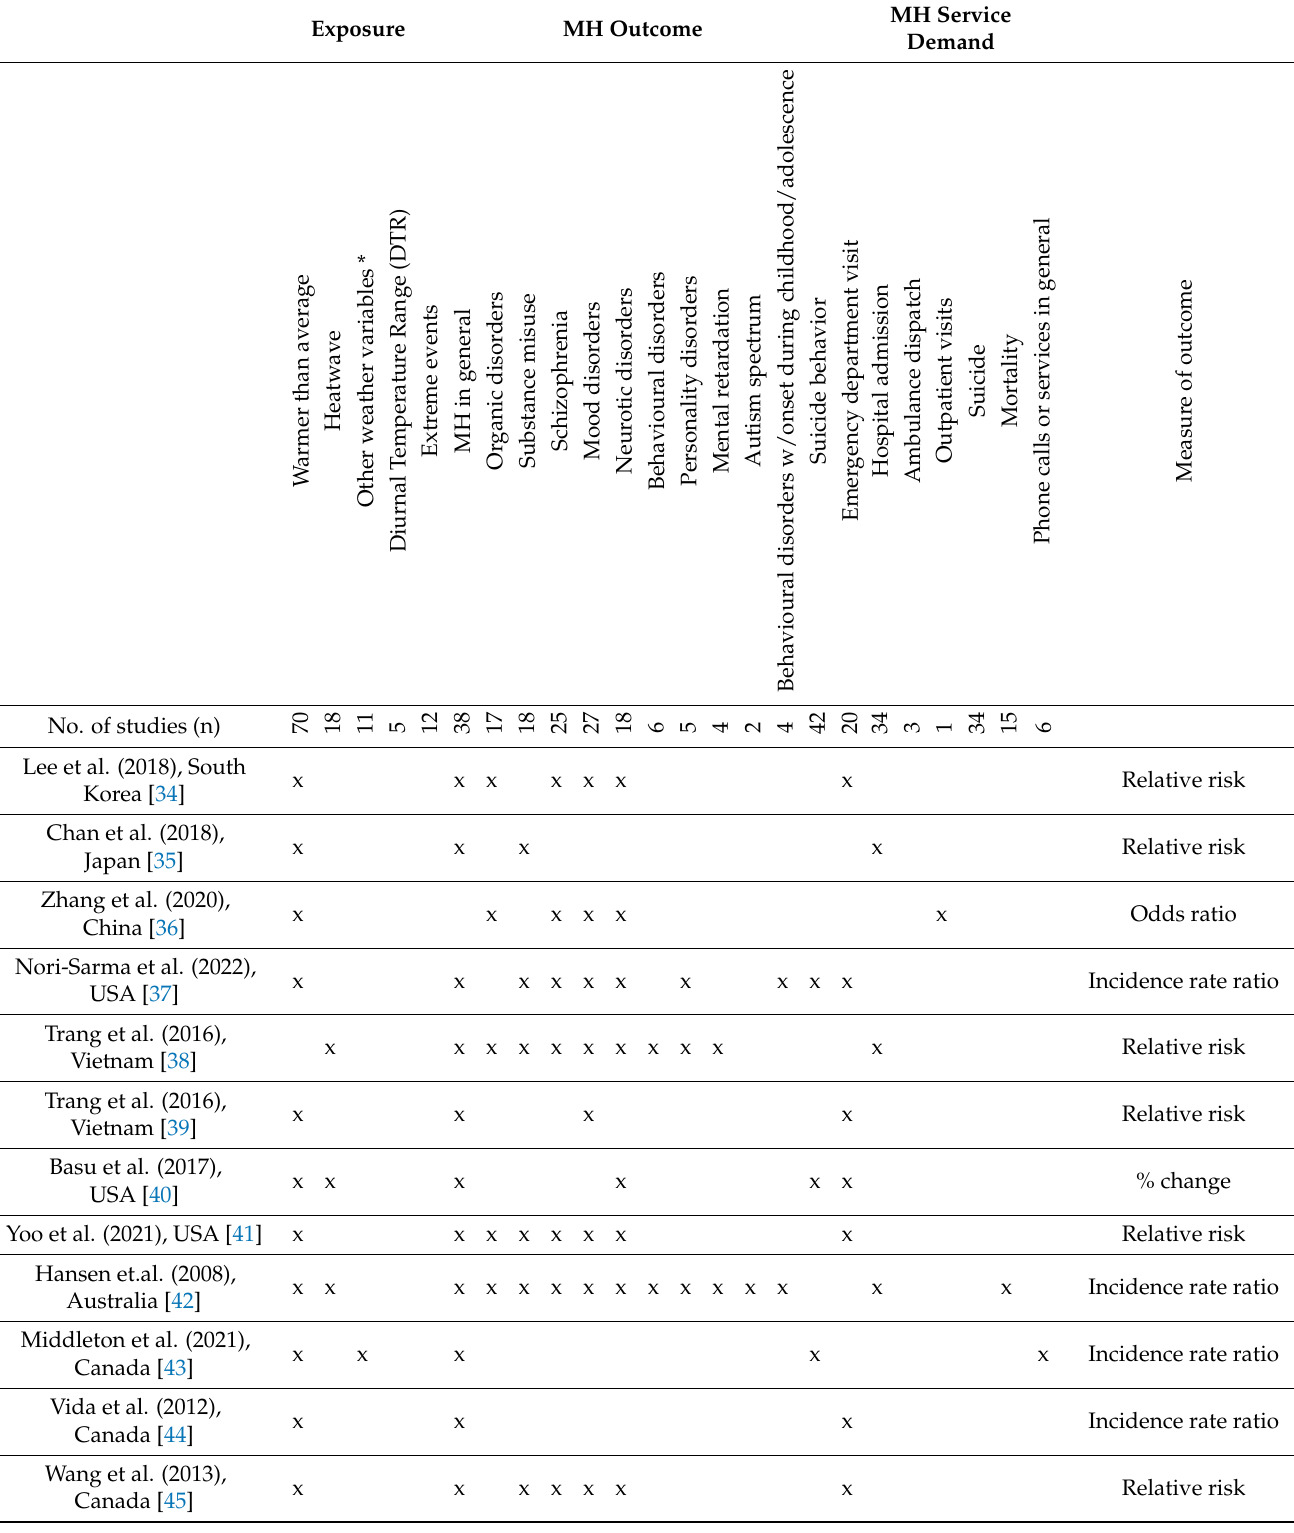
Table 2. General characteristics of all the included studies. * Weather variables included: snow and rain, temperature variability, temperature change between neighboring days, and daily excess hourly heat. The order studies were placed in the table was, as follows: MH in general or multiple types of disorders and, then, the sequence of specific ICD-10th, from F00 to F99. Mortality and suicide were placed next. Lastly, the extreme event-related